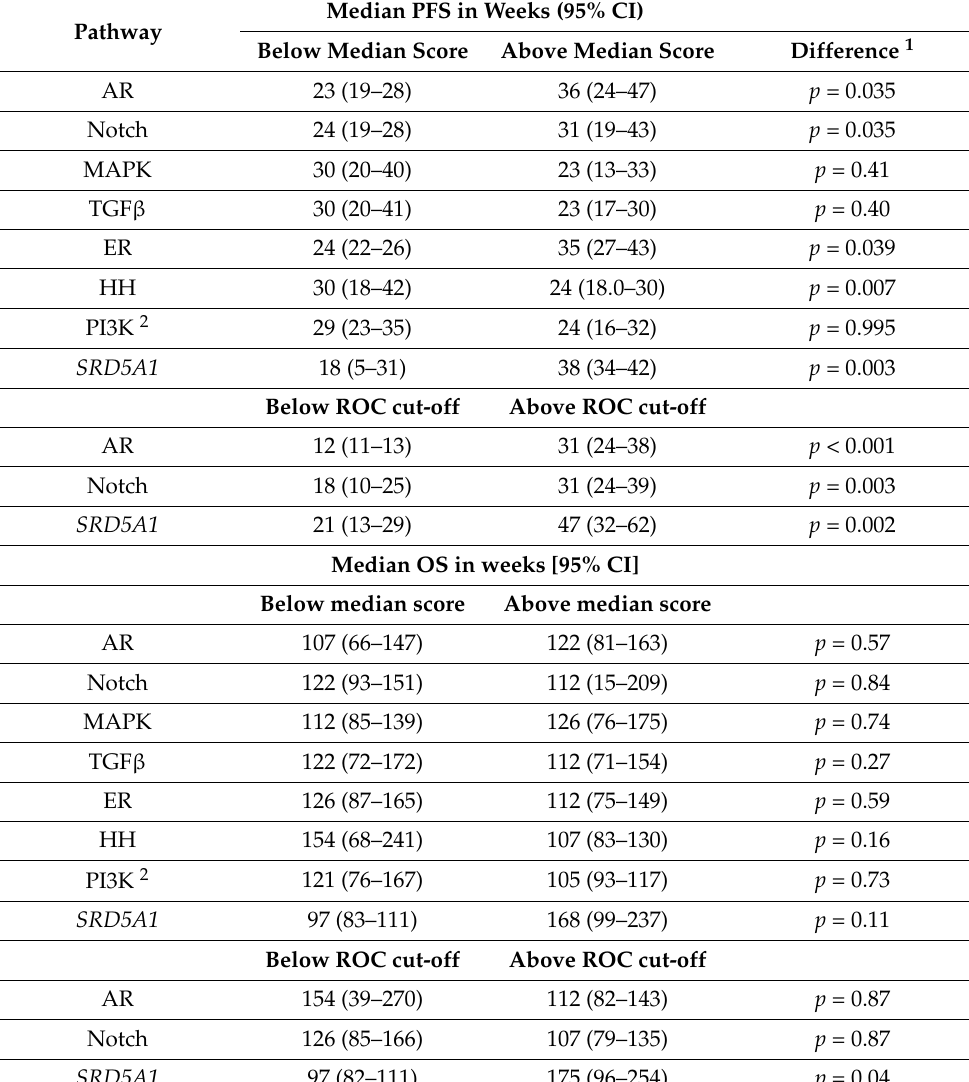
Table 3. Prognostic value of pathway activity scores and SRD5A1